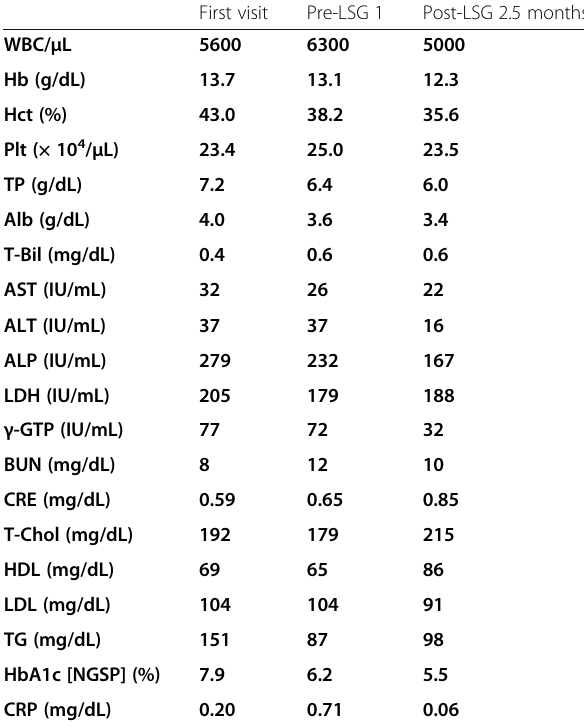
Table 1 Laboratory data obtained at the patient ’ s first visit, preoperative day 1, and 2.5 postoperative